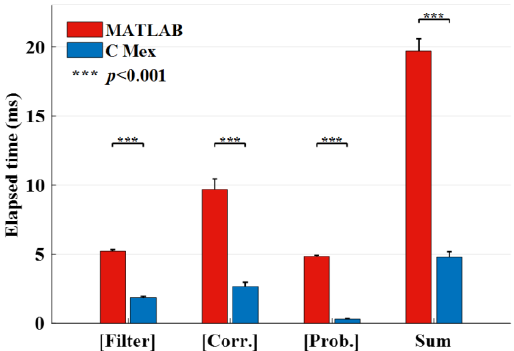
Figure 8. The average elapsed time of three online recognition procedures using MATLAB and C Mex.